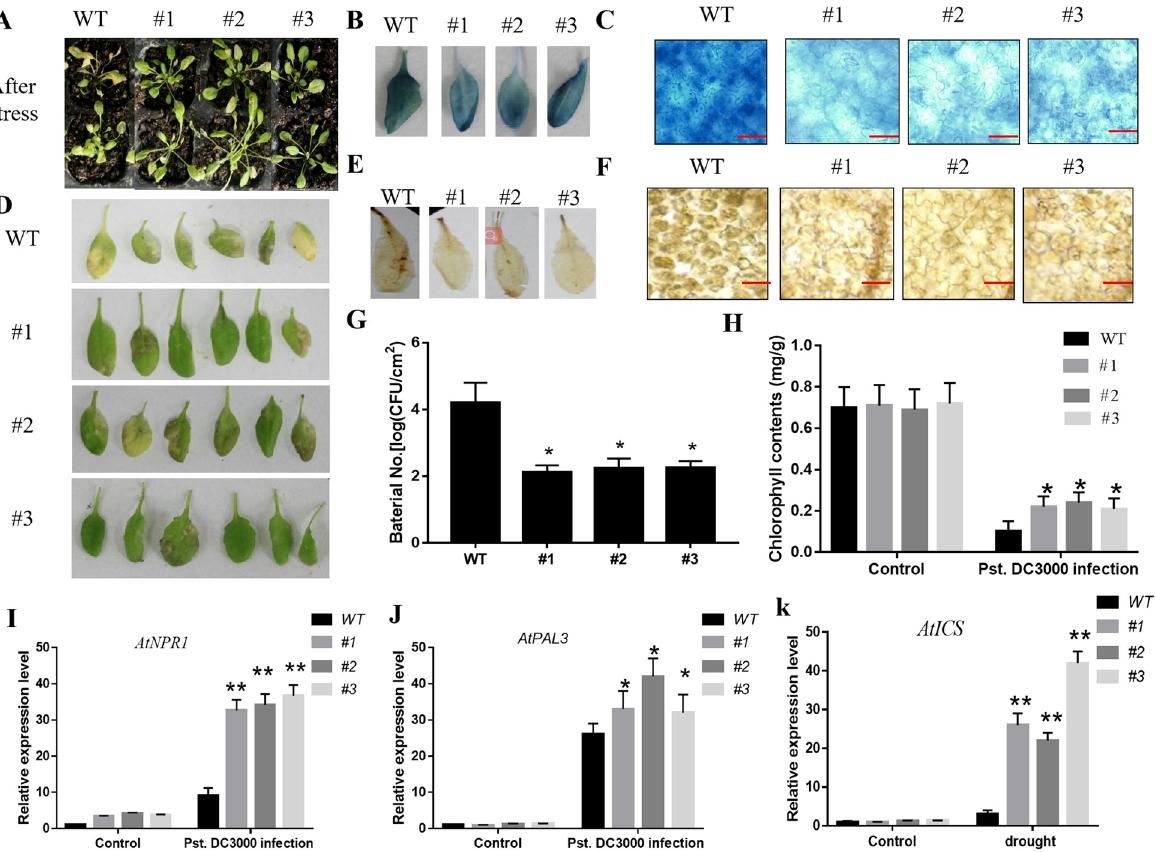
Fig. 8 Overexpression of CaSLP confers enhanced resistance to Pst.DC3000 stress in transgenic Arabidopsis. A , D Phenotype of transgenic and WT plants after the Pst.DC3000 infection. Plants were infected with Pst.DC3000 for 3 days. B , E Histochemical staining with 3,3’-diaminobenzidine (DAB) and Trypan blue for measuring the H 2 O 2 contents of the transgenic and WT plants after 3 d of Pst.DC3000 infection. Bar and DAB staining for cell death in the transgenic and wild-type (WT) plants after 3 d of Pst.DC3000 infection. G Bacterial numbers. H Chlorophyll contents in the transgenic and WT plants after 3 d of Pst.DC3000 infection. I - K The expressions of the SA response genes of AtNPR1, AtPAL3, and AtICS . Values are